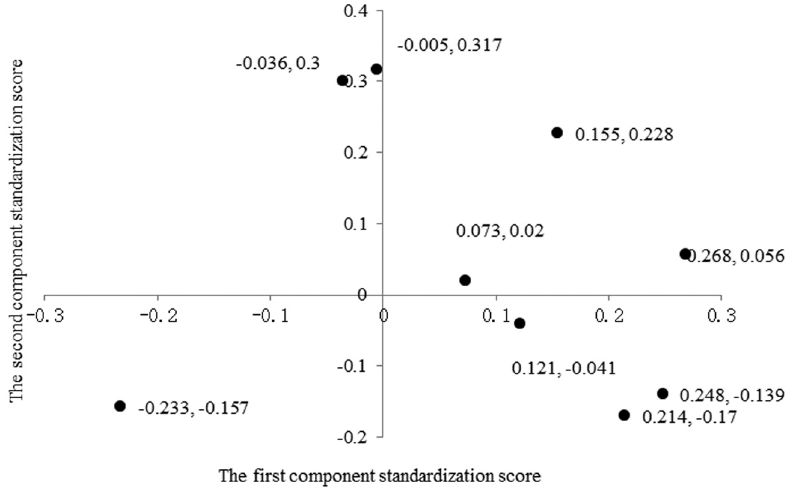
Figure 2: The bi - plot from a multivariate PCA analysis of the three root exudates compounds under phosphorus gradients